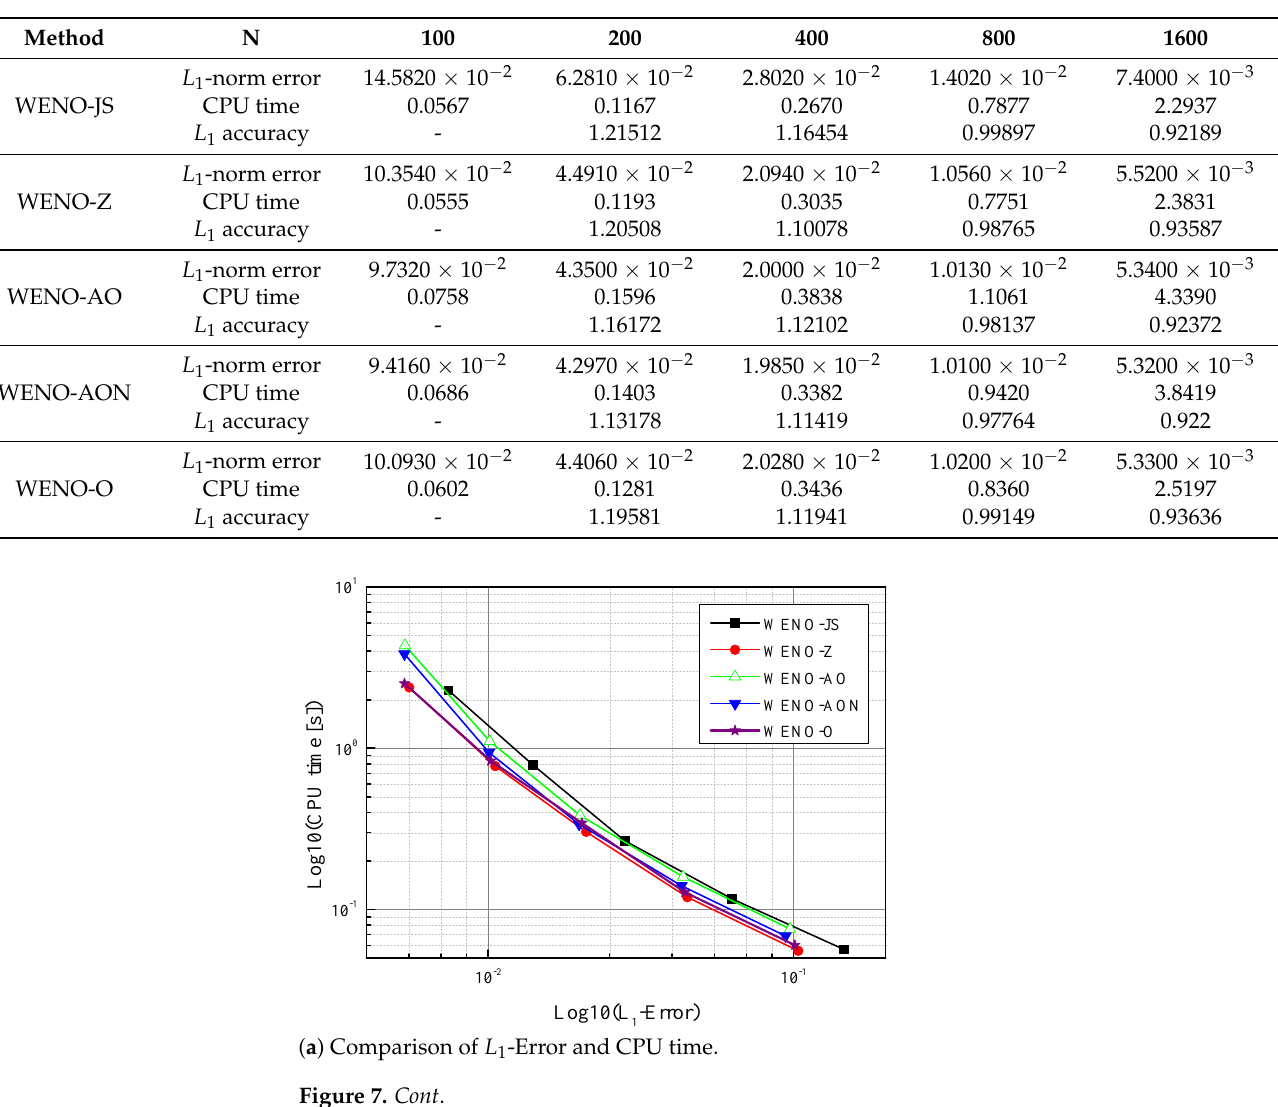
Table 5. The accuracy of scalar advection test of Example 3 (Section 6.1.3) in one dimension with WENO-AO, WENO-AON, WENO-JS, WENO-Z and WENO-O schemes.